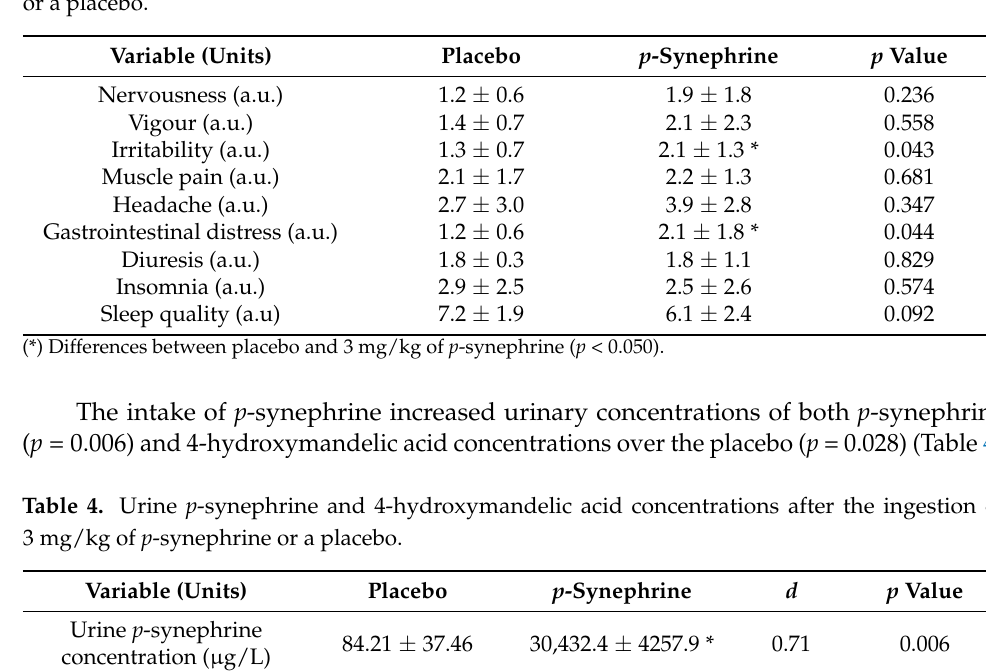
Table 3. Frequencies of side effects during the 24 h following the ingestion of 3 mg/kg of p -synephrine or a placebo.